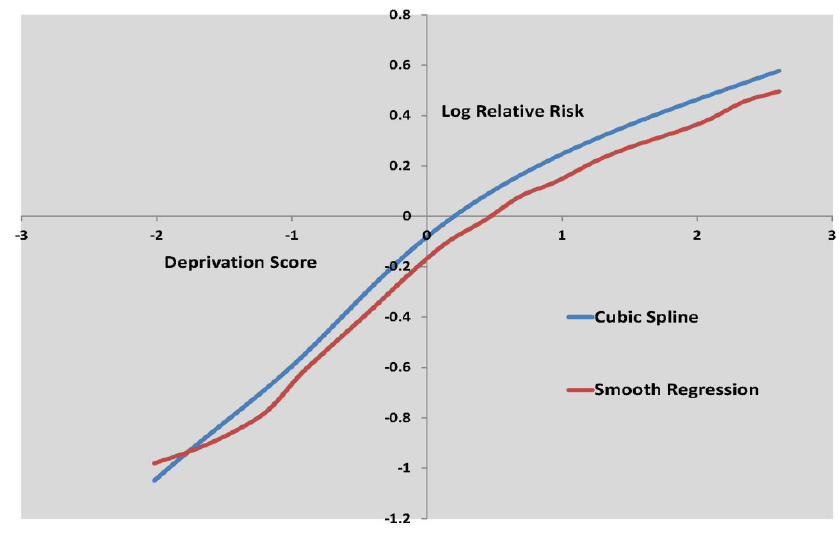
Figure 3. Log relative risk by deprivation score, cubic spline and smooth regression.